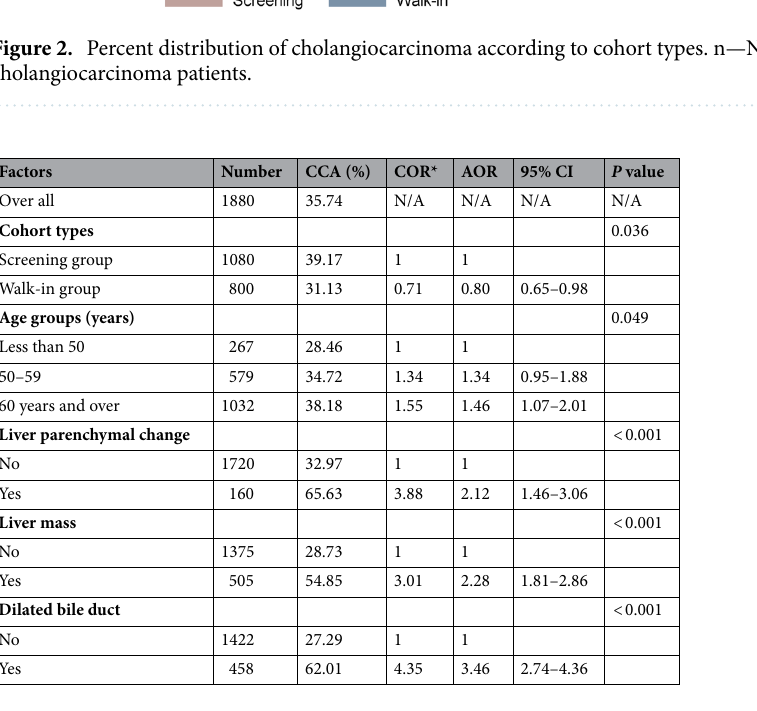
Table 3. Crude and adjusted odds ratio of association between ultrasound findings and cholangiocarcinoma using multiple logistic regression. N/A not applicable, CCA cholangiocarcinoma, COR crude odds ratio, AOR Adjusted odds ratio, 95% CI—95% confidence interval of adjusted odds ratio; P value—Probability values from likelihood-ratio chi-square tests; *All crude odds ratio represent statistically significant association, P value <